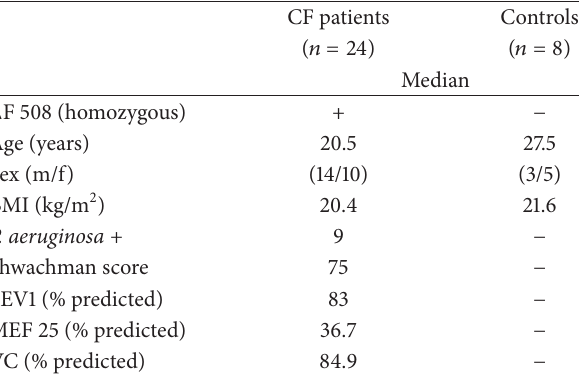
Table 1: Patients characteristics. CF